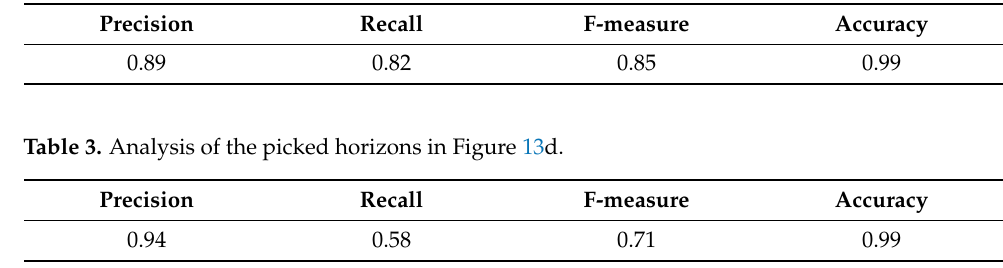
Table 2. Analysis of the picked horizons in Figure 13b.